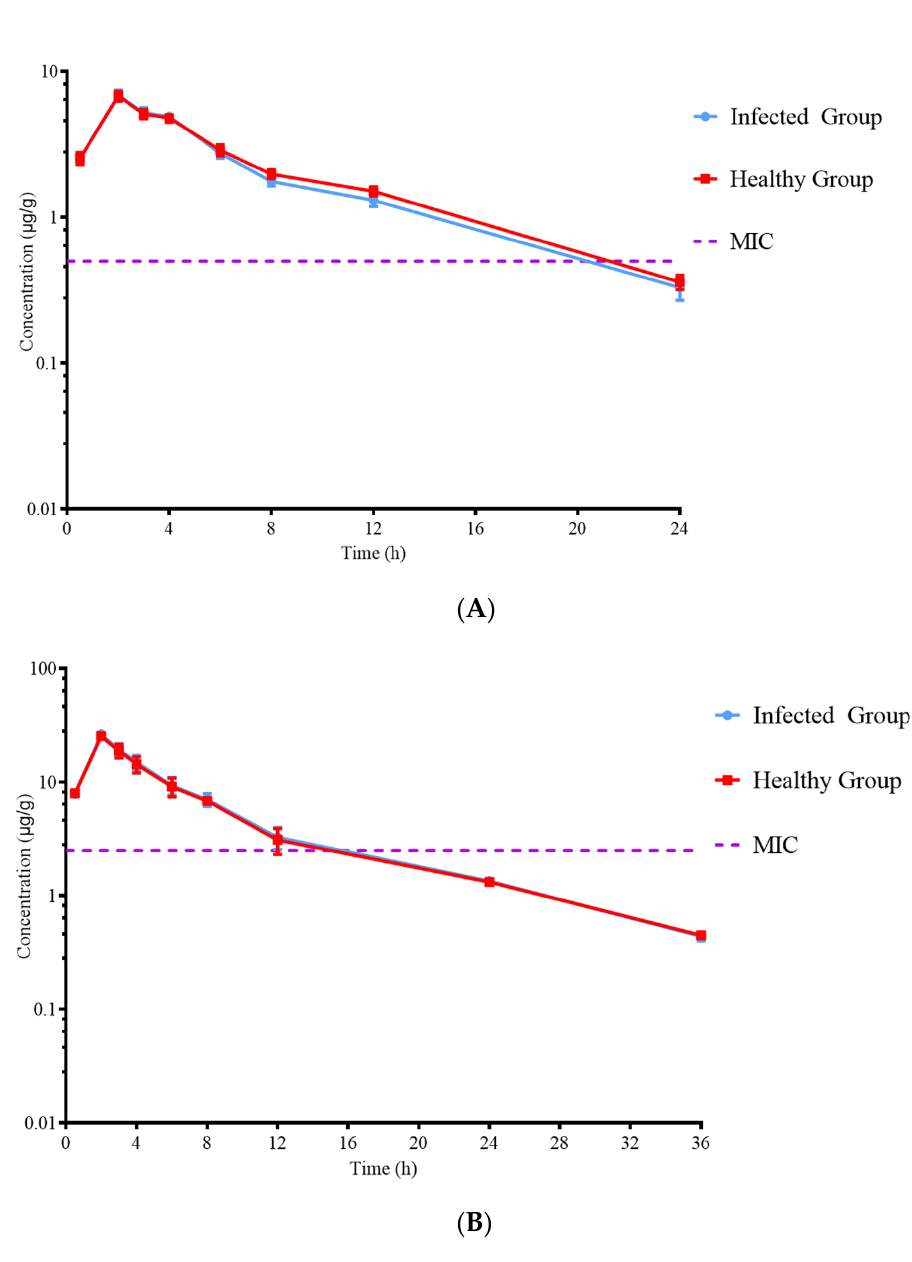
Figure 6. Concentrations of ADP ( A ) and SMZ ( B ) in PELF at various time points. After 24 h, the concentration of ADP and SMZ in plasma decreased below LOD, and after 36 h, the concentration of ADP and SMZ in PELF decreased below LOD. The fitting time of the model was 0–24 h, and the non ‐ compartment model was used. The parameters of ADP, SMZ, and ADP/SMZ compound in plasma and PELF were simulated with Win ‐ Nonlin (v.5.2.1 US Certara Pharsight ® ). The parameters are shown in Tables 4–6. Table 4. The PK parameters of ADP and SMZ in plasma after intramuscular injection of ADP/SMZ injection at 5/25 mg/kg b.w. of SMZ in swine ( n = 6). Parameters